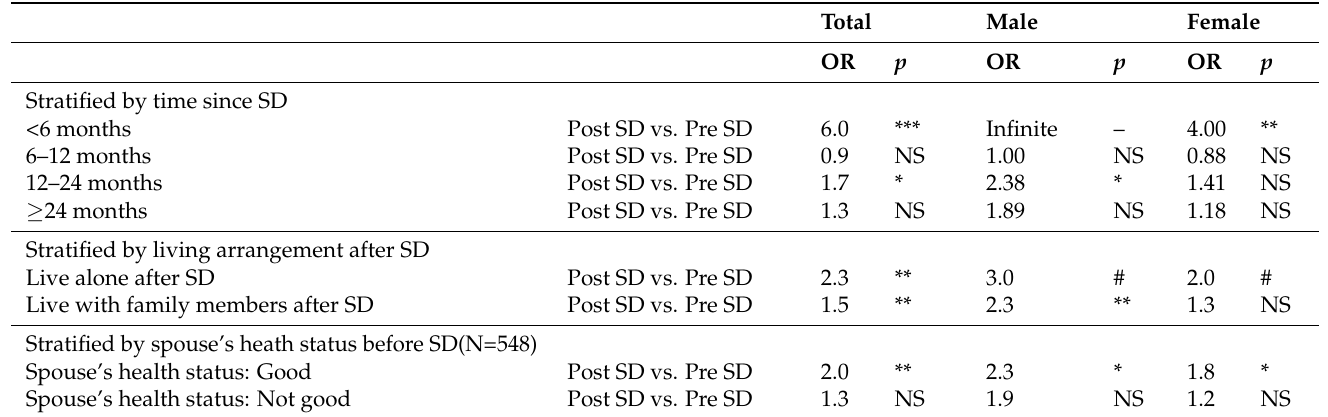
Table 6. Effect of spouse death on depression: stratification